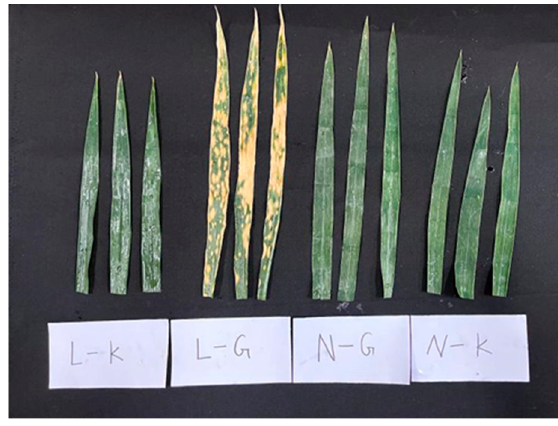
Figure 9. Four groups of leaf samples with three